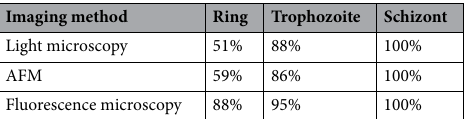
Table 3. Success rate of asymmetric cuts going through the